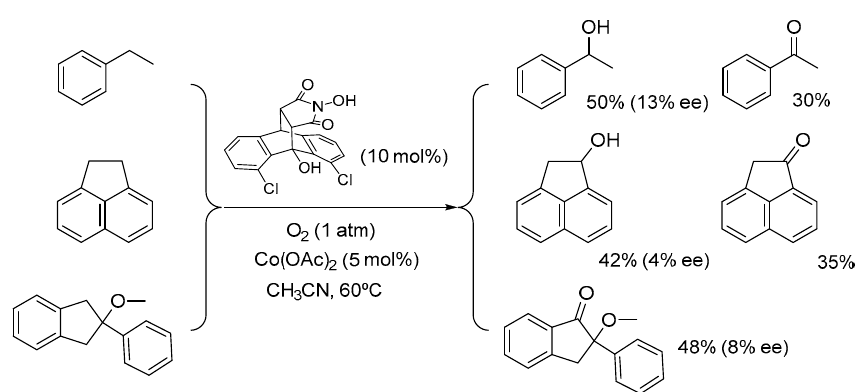
Figure 2. Structure of Py-NHPI prepared by Wang et al.